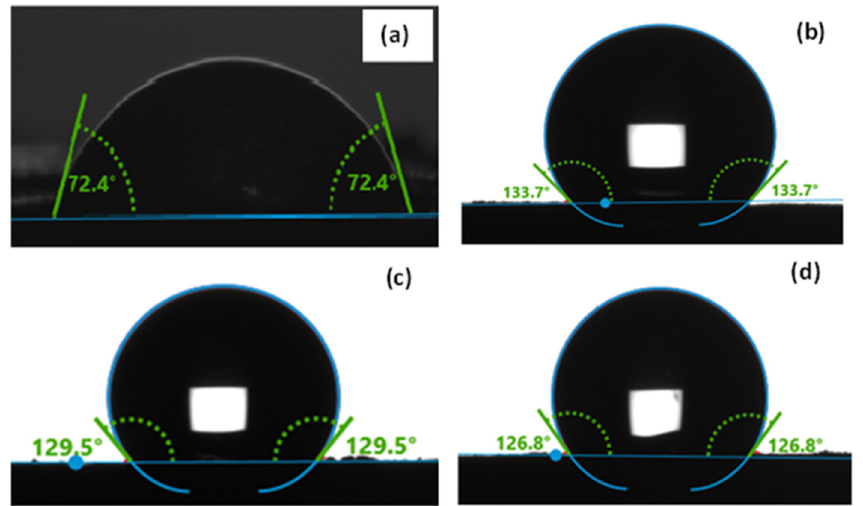
Figure 3. Water contact angle of: ( a ) commercial graphene oxide (GO); ( b ) PtrGO1; ( c ) PtrGO2; ( d ) PtrGO3. The thermogravimetric analysis of the commercial graphene oxide (GO) and PtrGO1, PtrGO2 and PtrGO3 samples is presented in Figure 4.